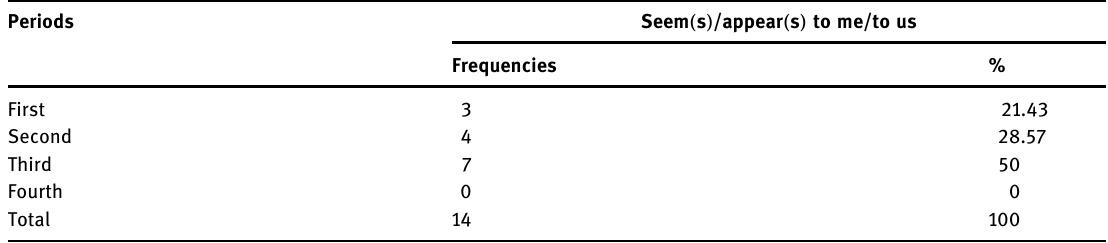
Table 13: Frequencies and percentages of the verbs “ seem ( s ) to me/us ” and “ appear ( s ) to me/us ” in the four time periods Periods